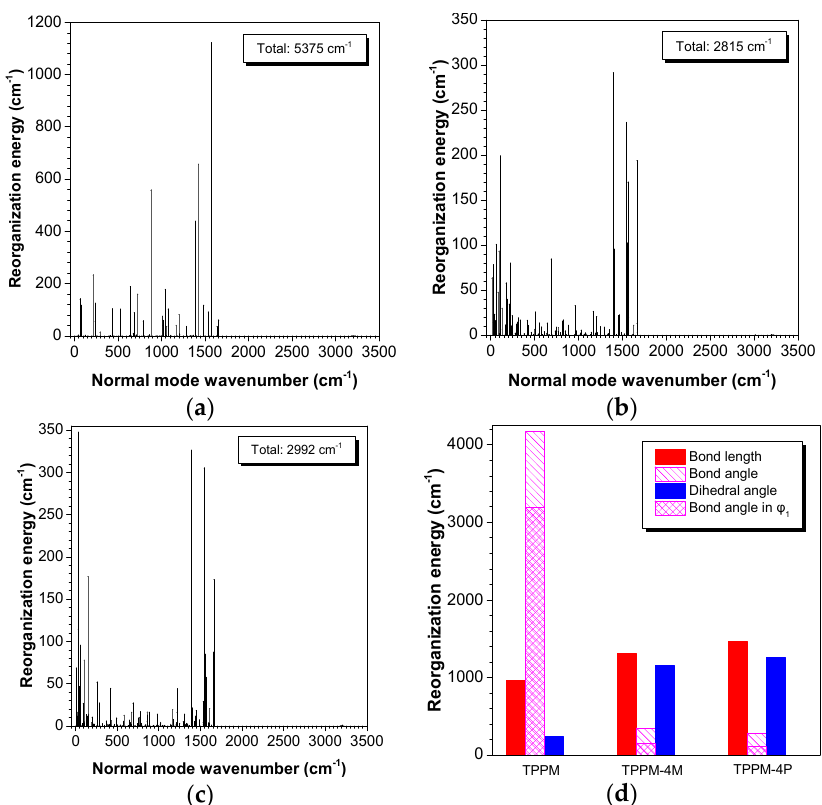
Figure 4. Presentation of the calculated reorganization energy versus the normal mode wavenumbers for ( a ) TPPM, ( b ) TPPM-4M, ( c ) TPPM-4P, and ( d ) contribution to the total reorganization energy from